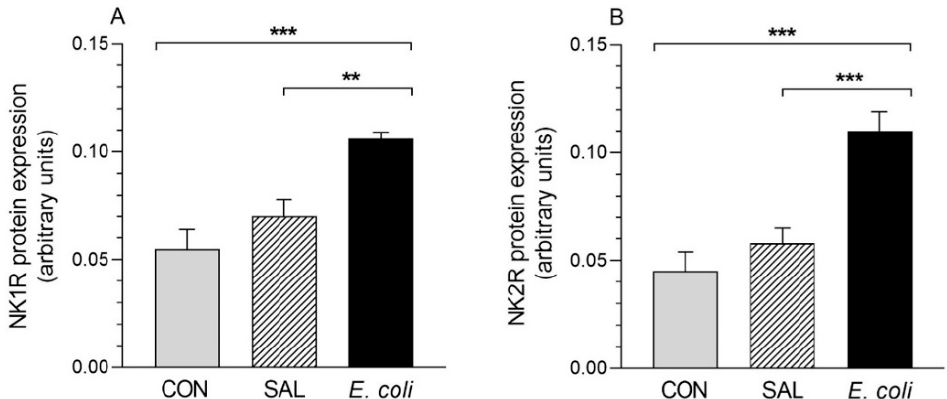
Figure 1. The protein expression of NK1R ( A ) and NK2R ( B ) in the porcine myometrium from the control (CON), saline (SAL) and E. coli groups, estimated by Western blot analysis. Blots with representative bands for each group are shown in Supplementary Figure S1. Protein levels of studied receptors are expressed as the mean ± SEM of ratios of glyceraldehyde-3-phosphate dehydrogenase (GAPDH). ** p < 0.01, *** p < 0.001 compared between groups for the same type of receptor.